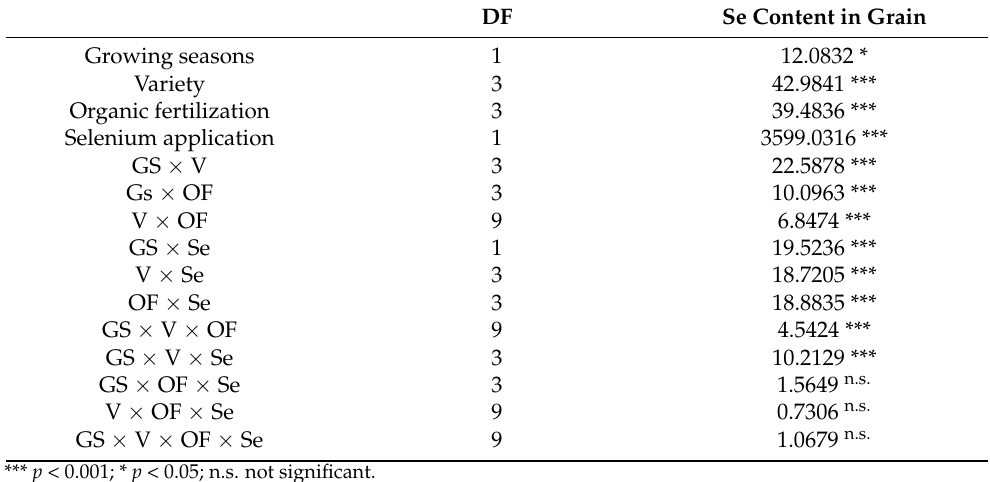
Table 1. F-value growing season (GS), variety (V), organic fertilization (OF), selenium application (Se), and their interactions on the Se content in grain resulting from analysis of variance (ANOVA).